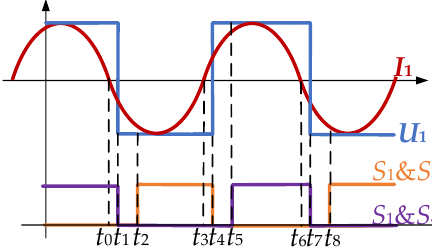
Figure 6. Waveforms of U 1 & I 1 and gate signals of the inverter in a full switching cycle with f d < f r . Previous analyses indicate that, when the zero-cross point of I 1 is shifted out of the dead-time, only one pair of the body diodes is conducting during the dead-time, and the MOSFETs can achieve